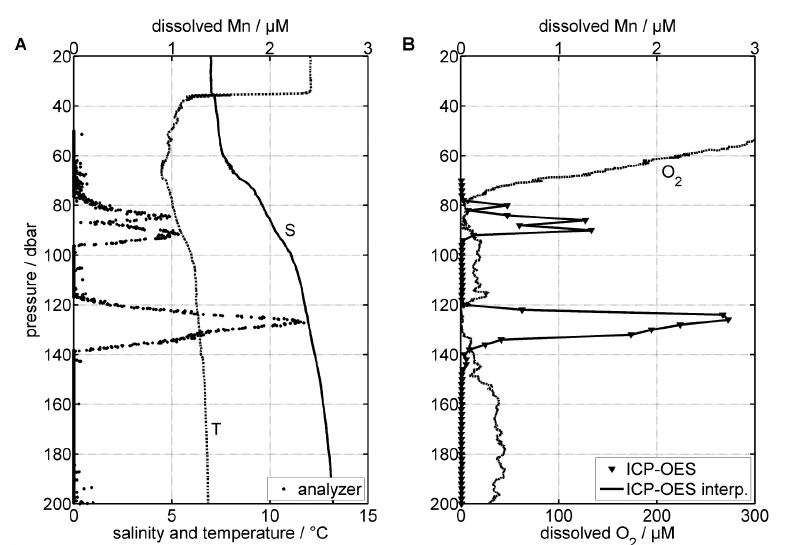
Figure 6. Data from the October 2015 cruise. Vertical profiles of ( A ) temperature, salinity, and dissolved Mn concentrations (METals In Situ analyzer system, METIS); ( B ) dissolved O 2 and dissolved Mn concentrations (inductively coupled plasma–optical emission spectrometry,